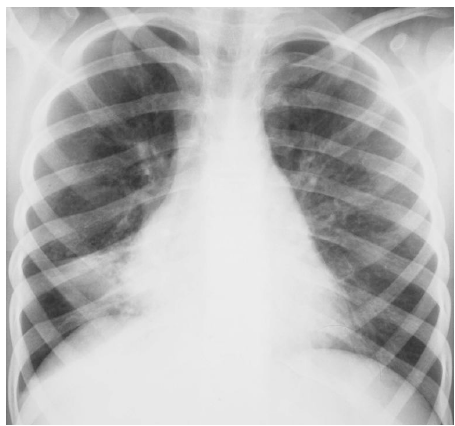
Figure 1. Chest radiography of a 7-year-old girl with middle lobe syndrome.